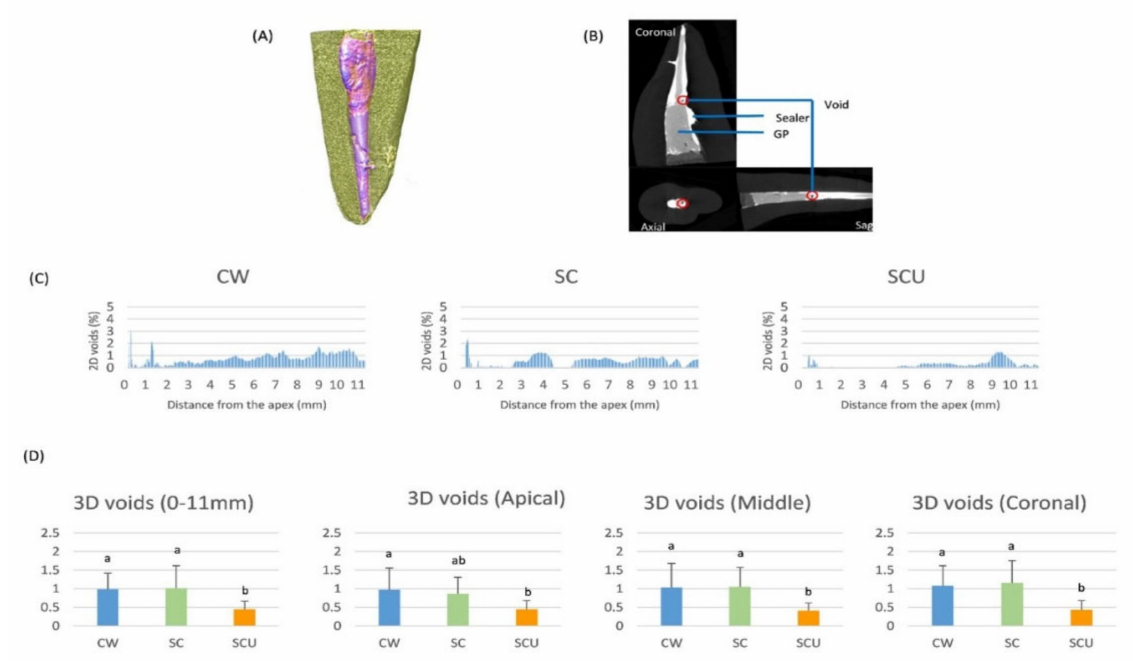
Figure 1. Micro-CT images of a representative specimen and Micro-CT analyses of 2D and 3D quantifications of void volumes. ( A ) Representative 3D images produced from the grayscale thresholds of filling materials. ( B ) Representative 2D images of coronal, axial, and sagittal views, which are shown for the volume of interest (VOI). The root structure, gutta percha (GP), and sealer can be differentiated by the value of their different grayscale levels. Interfacial gaps and voids can be identified within the root filling. ( C ) Examples of 2D area of gaps and voids in the roots obturated by AH Plus with the continuous wave technique (CW group), EndoSequence BC sealer with the single-cone technique (SC group), and EndoSequence BC sealer with the single-cone technique accompanied by ultrasonic activation (SCU group). ( D ) The 3D percent volume of voids within the entire root, from the apex (0 mm) to 11 mm coronal to the apex, apical (0–3 mm) level, middle (3–7 mm) level, and coronal (7–11 mm) level. Bars identified with the same lowercase letter are not significantly different ( p >